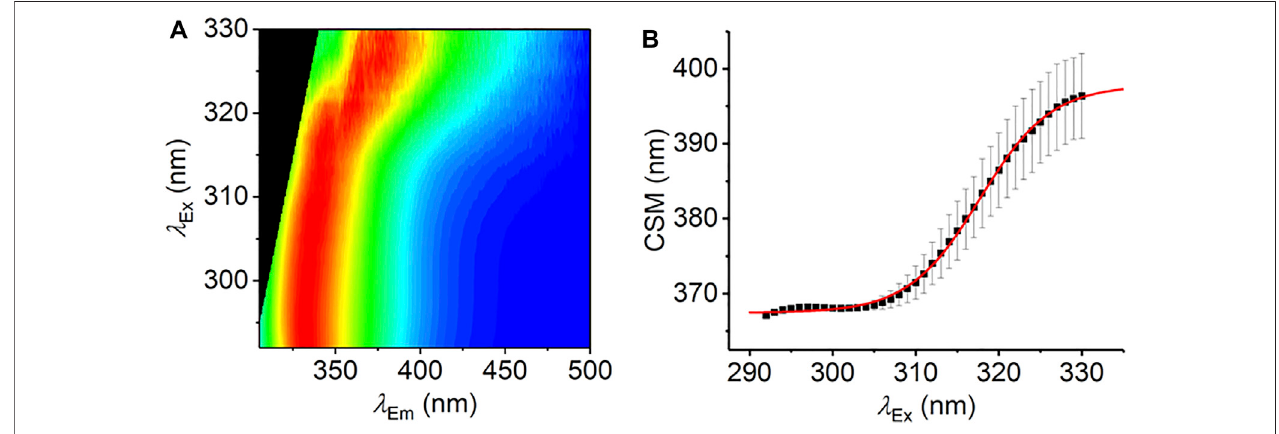
FIGURE 3 | The REES effect monitored over extended λ Ex range. (A) Averaged, normalized raw emission spectra. (B) CSM data extracted from λ Em (cid:2) 340 – 500 nm. The solid red line is the fi t to Eq. (7) . Data collected in triplicate; error bars are the standard deviation. Conditions: 1.25 mM L-Trp, MeOH, 25 °